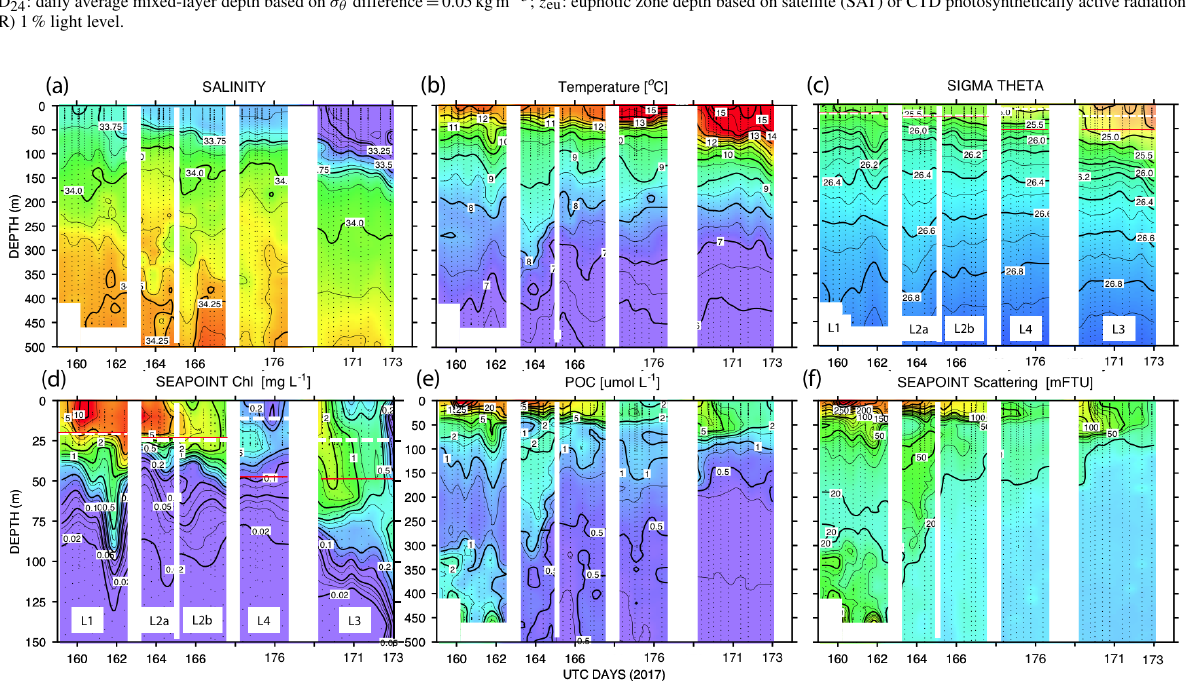
Figure 11. (a) Salinity, (b) temperature, (c) sigma theta ( σ θ ), (d) chlorophyll fluorescence, (e) transmissometer-derived POC, and (f) turbidity time series from CTD casts. The time axis (in UTC days since 1 January 00:00 2017) has been reordered so that L1, L2, and L4 are grouped. L3 is shifted to the right side of each panel. The white dashed line and red line (c) and (d) denote averaged 24h mixed-layer depths and euphotic zone depths, respectively. The chlorophyll fluorescence (d) depth axis is 150m; the limit of detection was 0.02